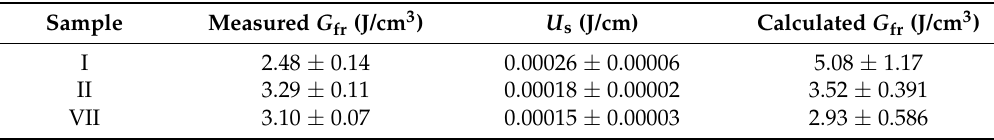
Table 5. Fracture energies for sintered 316L SSFFs and single fiber.